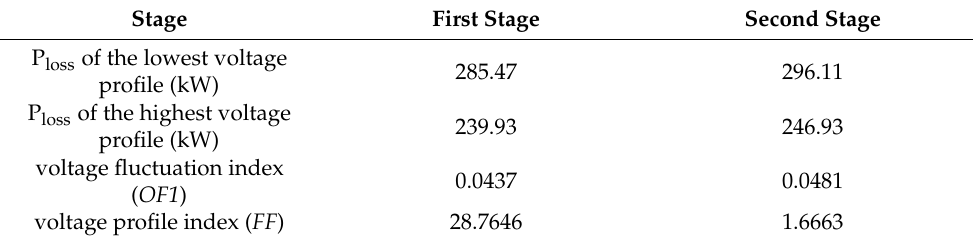
Figure 9. Voltage profiles after adjusting voltage regulating devices. Table 5. Objectives values after applying the first and second stages.